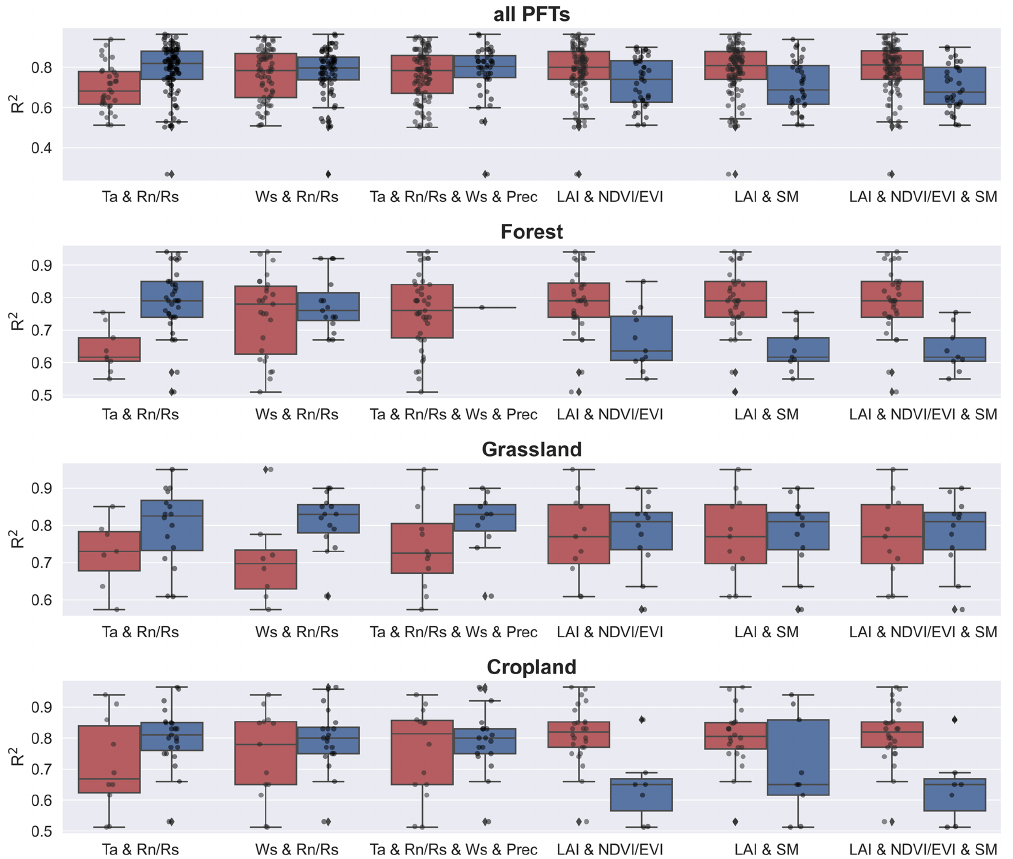
Figure 5. Effects of combinations of predictor variables on model accuracy in various PFTs (all data, forest, grassland, and cropland). Dark blue boxes indicate that the predictors were used together in the model (e.g., for “ T a & R n /R s ”, the dark blue box represents T a and R n /R s were together used in the model), while dark red boxes indicate the other conditions (i.e., the combination was not used). Predictors: precipitation ( P ), soil moisture/remote-sensing-based land surface water index (SM), net radiation / solar radiation ( R n /R s ), enhanced vegetation index (EVI), air temperature ( T a ), leaf area index (LAI), and normalized difference vegetation index/enhanced vegetation index